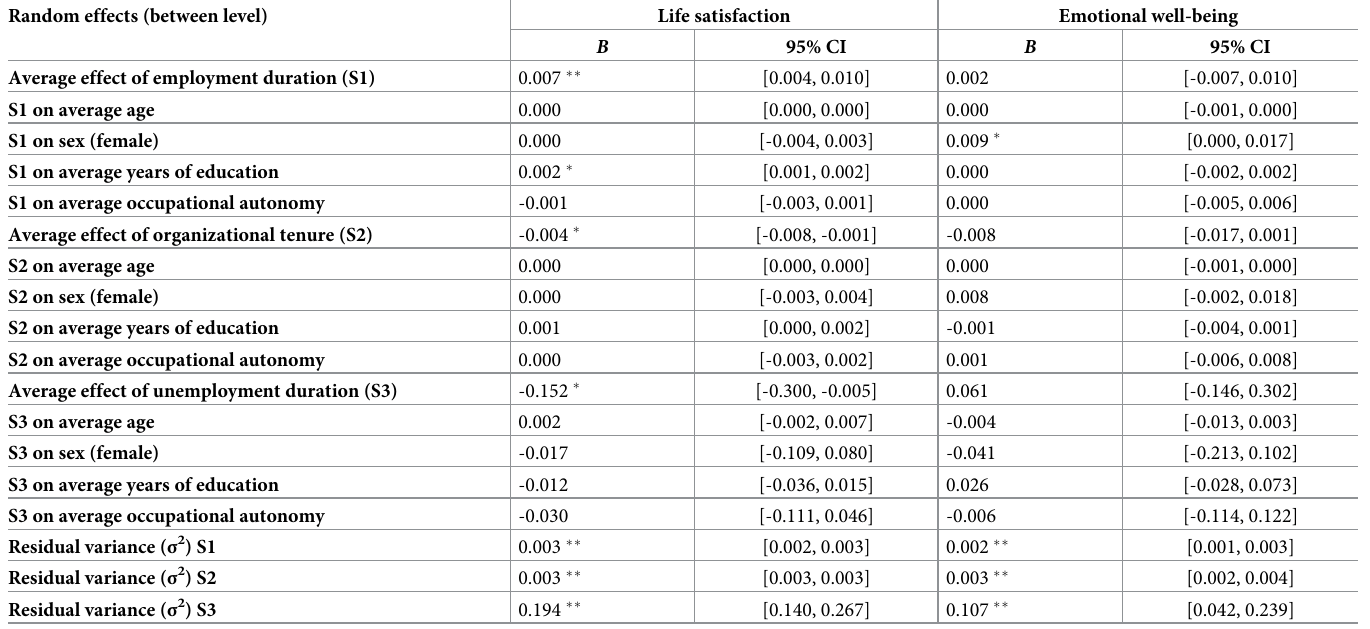
Table 6. Moderation of the total within-level effects of employment status duration on SWB by between-level predictors. Random effects (between